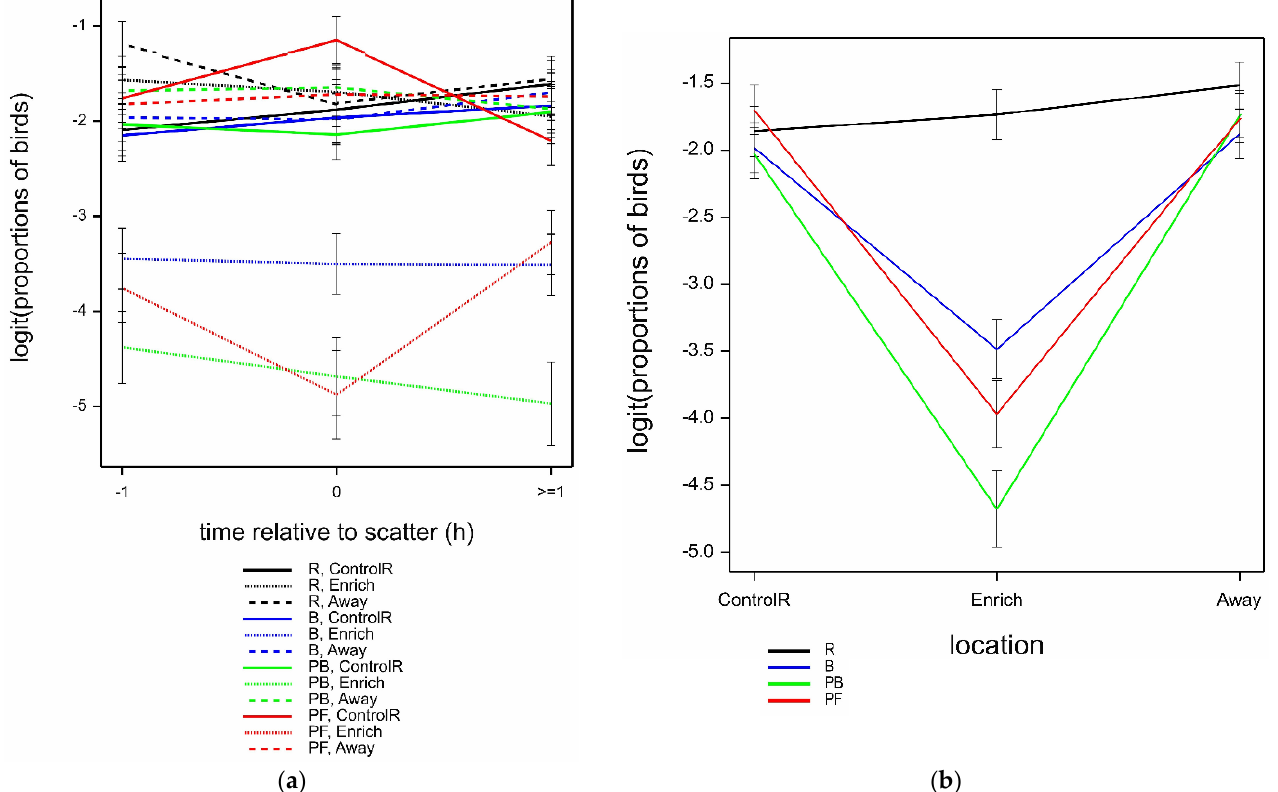
Figure 8. ( a ) Mean ± SE logit (proportions of birds) observed in walk/run behaviour, according to time ( − 1, 0, ≥ 1), location (ControlR, Enrich, Away) and treatment (R, B, PB, PF), estimated from GLMM. ( b ) Mean ± SE logit (proportions of birds) observed in walk/run behaviour, according location (ControlR, Enrich, Away) and treatment (R, B, PB, PF), estimated from GLMM.